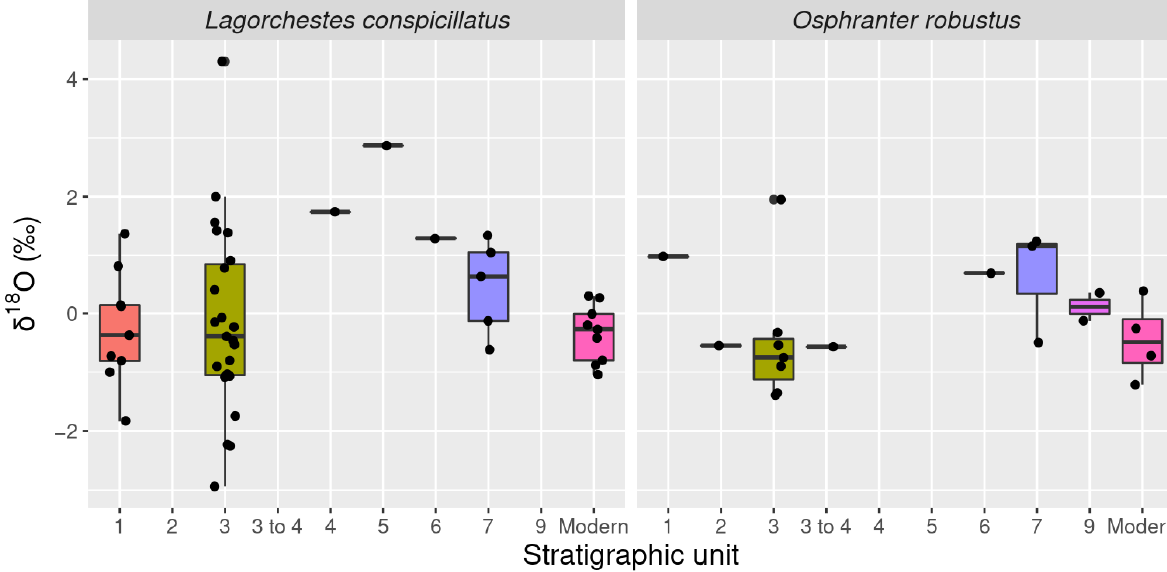
Figure 9. Box plot L. conspicillatus and O. robustus δ 18 O by stratigraphic unit.